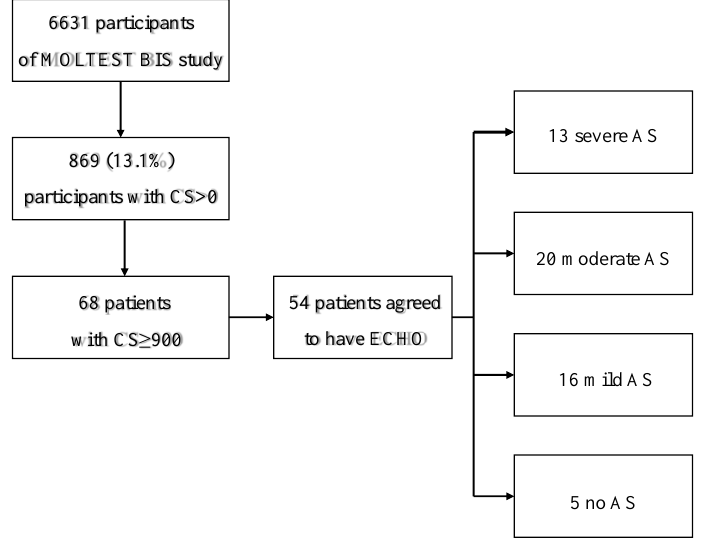
Figure 1. Algorithm of patient inclusion.